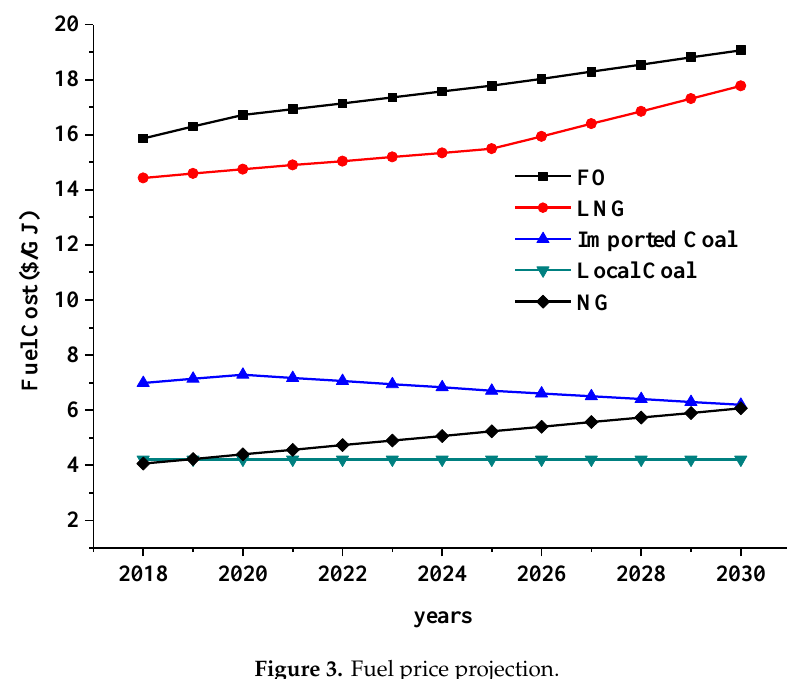
Figure 3. Fuel price projection.